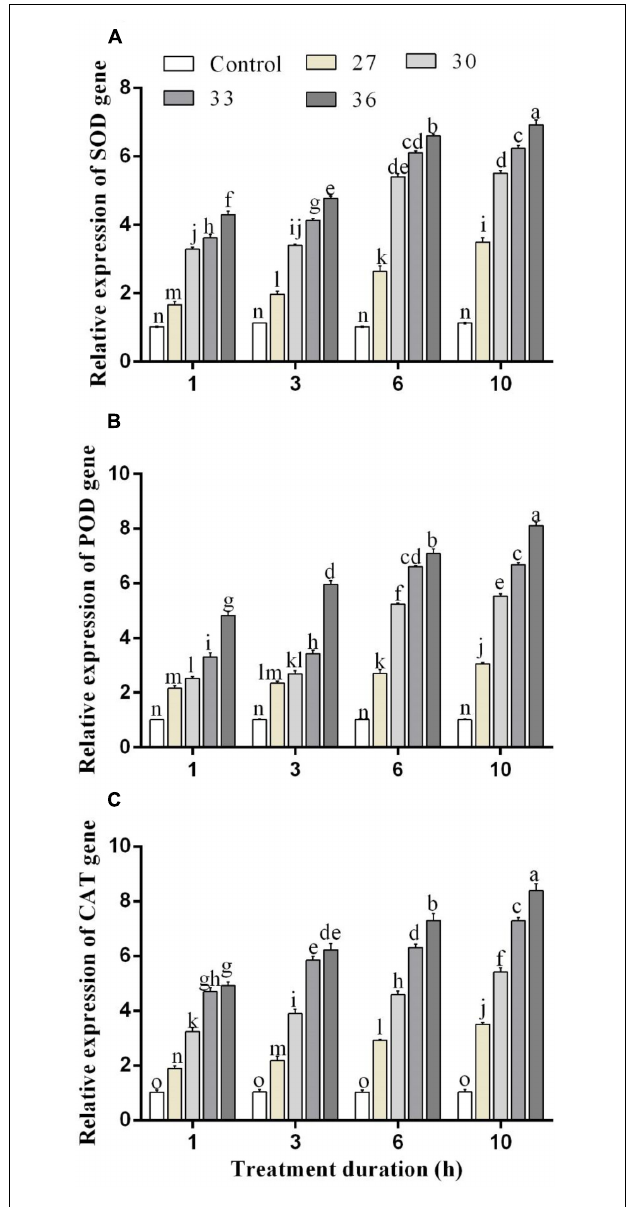
FIGURE 4 | Relative expression of (A) SOD, (B) POD, and (C) CAT genes in M. persicae under different heat stresses (27, 30, 33, and 36 ◦ C) at different durations (1, 3, 6, and 10 h) in growth chambers. Small bars represent the standard errors of the means. Different lower case letters indicate significant differences between treatments at Tukey’s HSD test ( p < 0.05) using one-way